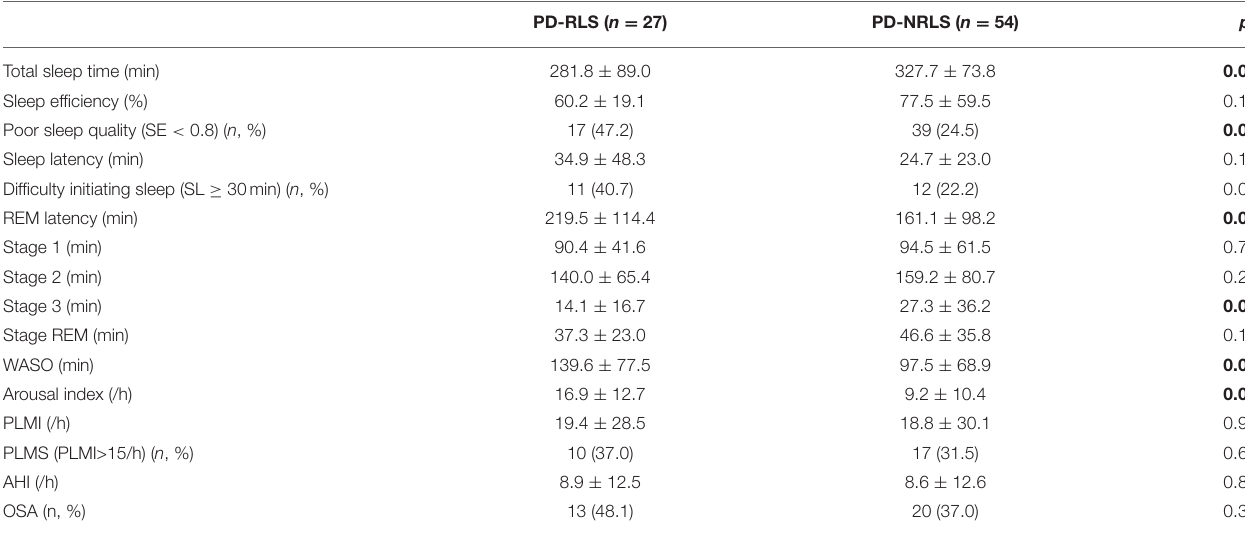
TABLE 2 | Sleep parameters of PD patients with and without